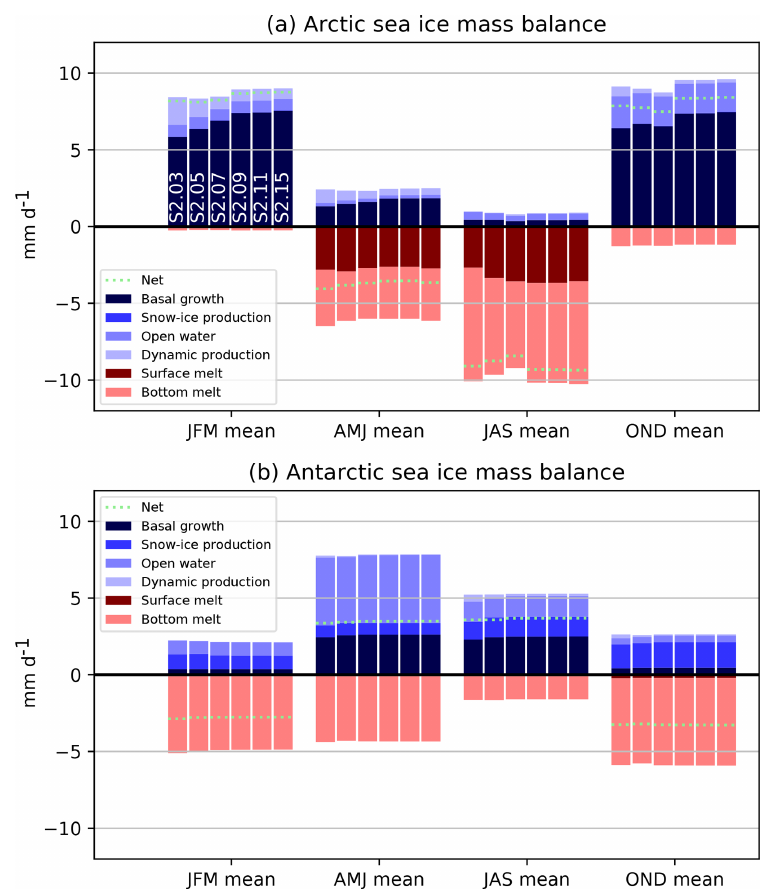
Figure A2. Contributions to the seasonal mass balance of Arctic (a) and Antarctic (b) sea ice as simulated in the second set of sensitivity experiments (S2) (appending thick ice categories), averaged over the areas depicted in Fig. A1. Blue colors refer to processes that contribute to positive ice volume changes, while red colors indicate processes implying negative ice volume changes. The name of the experiments is indicated in the upper panel for the January–February–March